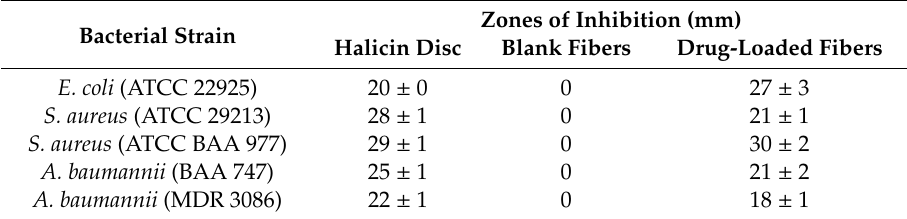
Figure 10. Zone of inhibition of the drug-loaded electrospun fibers compared to an equivalent concentration of the free drug in a sterile disc. The zone of inhibition of the drug-loaded fibers was 27 mm, 21 mm, 30 mm, 20 mm, and 18 mm for E. coli ( A ), S. aureus ATCC 29,213 ( B ), S. aureus BAA 977 ( C ), A. baumannii BAA-747 ( D ), and MDR A. baumannii ( E ), respectively, while it was 20 mm, 28 mm, 28 mm, 24 mm, and 21 mm for the halicin discs, respectively. Table 1. The zone of inhibition diameters of halicin discs, blank and drug-loaded fibers against E. coli (ATCC 22925), S. aureus (ATCC 29213), S. aureus (ATCC BAA 977), A. baumannii (BAA 747), and A. baumannii (MDR 3086). Both the drug-loaded fibers and halicin discs showed clear zones of inhibitions against all bacterial strains, while the blank fibers showed no e ff ect against those bacteria. The results represent the mean ( ± SD) of n =